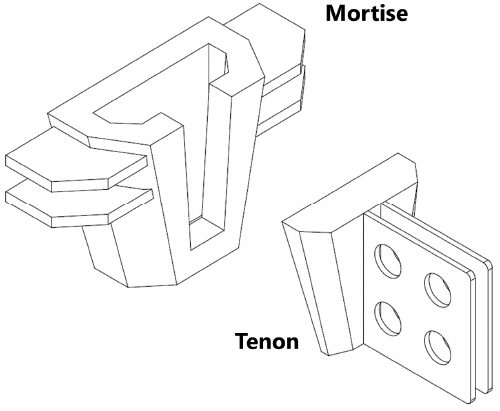
Figure 1. Advanced Technology for Large Structural Systems (ATLSS) beam-to-column connection.